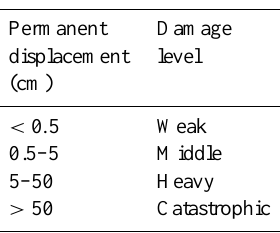
Table 5. Damage scale depending on permanent displacement val- ues (after Crespellani et al., 1990).